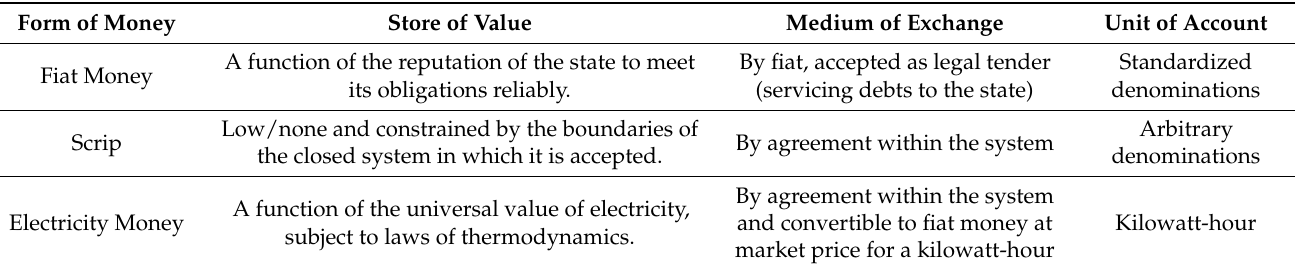
Table 2. Comparison of Selected Types of Near